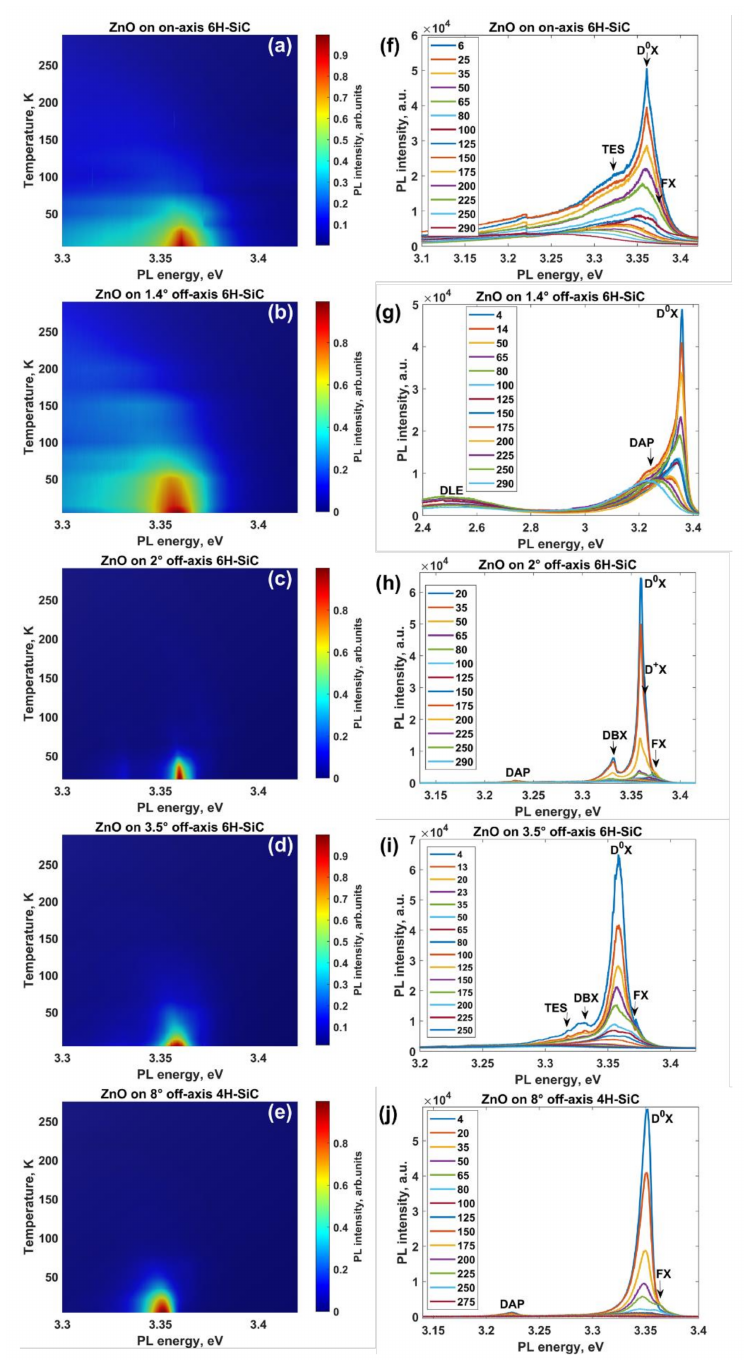
Figure 3. PL contour plots of temperature-dependent ultraviolet emission ( a – e ) and corresponding PL spectra ( f – j ) of ZnO films grown on SiC substrates with different off-cut angles: 0 ◦ ( a , f ), 1.4 ◦ ( b , g ), 2 ◦ ( c , h ), 3.5 ◦ ( d , i ), and 8 ◦ ( e , j ), respectively. Since the low-intensity spectral features with peak energies smaller than 3.3 eV cannot be easily seen against the blue background of PL contour plots, we did not visualize the spectral range from 2.4 to 3.3 eV, as that is less informative for readers. Note: Spectral features observed for ZnO on on-axis 6H-SiC in the range 3.2 to 3.25 eV are not luminescence features but originate most likely from a change within the grating system of the dispersing